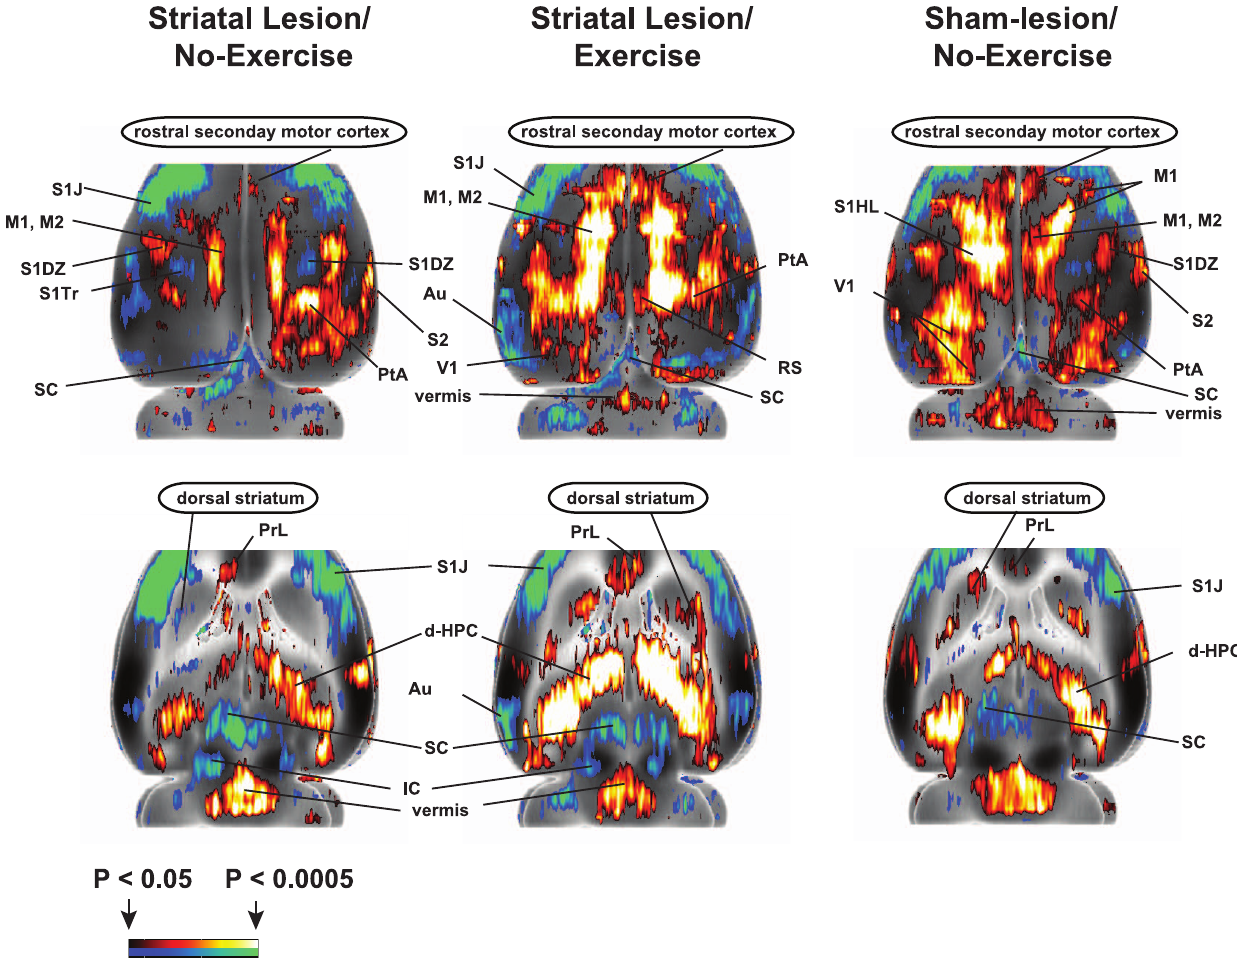
Figure 7. Functional activation of dorsal striatum (d-CPu) and rostral secondary motor cortex (rostral M2). Activation is attenuated after lesioning and is augmented by exercise training (ET). Row 1 depicts a top-down view of the cerebral cortex, while row 2 shows activation at a transverse slice at the level of the dorsal striatum (AP + 3.7 mm to AP 2 10.6 mm). Significant changes are shown for the walk-vs.-rest comparison. Colored overlays show statistically significant positive (red) and negative (blue) differences (voxel level, P , 0.05). Abbreviations are those noted in the legend of Fig. 5.